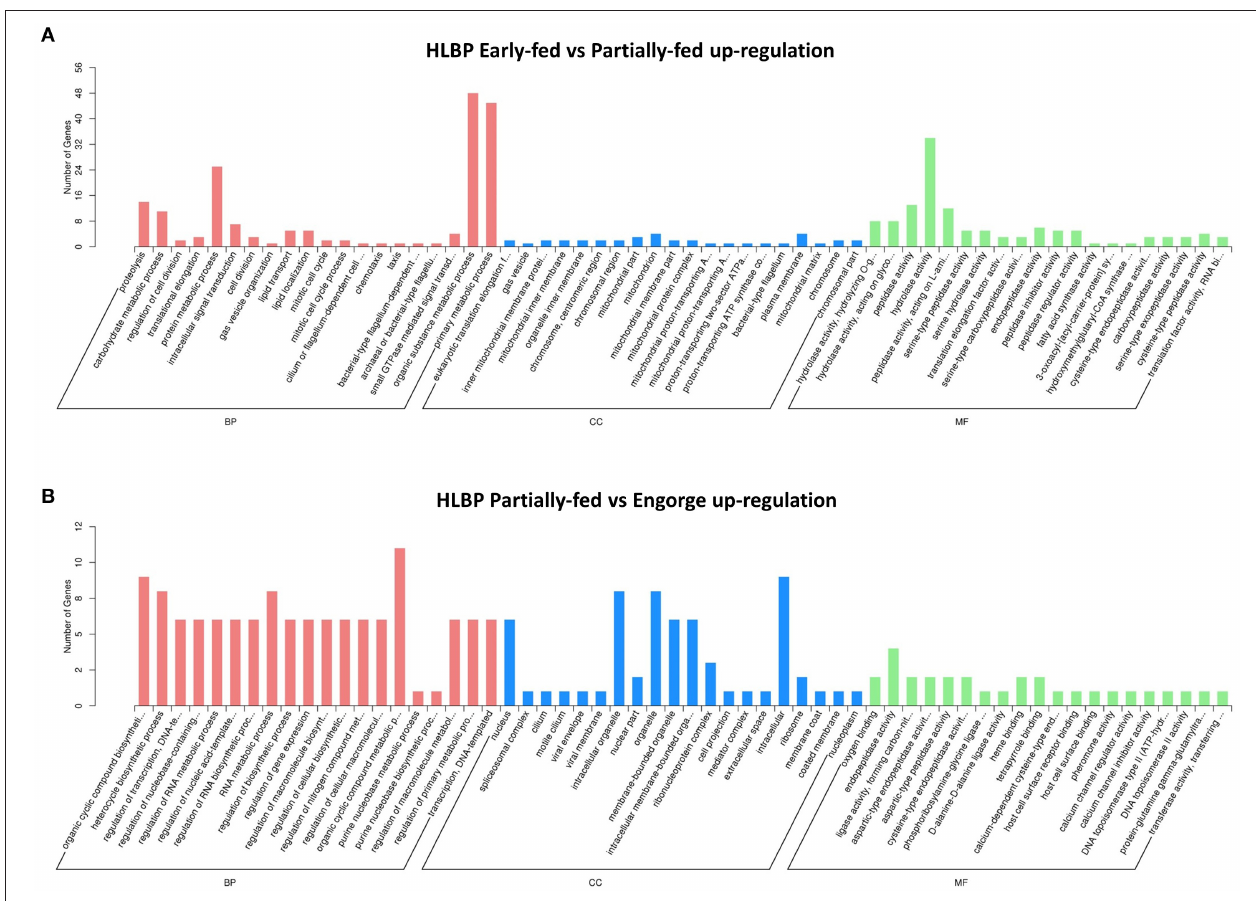
FIGURE 3 | Gene Ontology (GO) annotation enrichment of upregulated proteins in bisexual H. longicornis (HLBP) at different feeding stages. The x-axis shows the functional categories of the proteins, and the y-axis shows the number of increased proteins. (A ) Comparison of bisexual H. longicornis (HLBP) in early-fed to partially-fed stages. (B) Comparison of bisexual H. longicornis (HLBP) in partially-fed to engorge